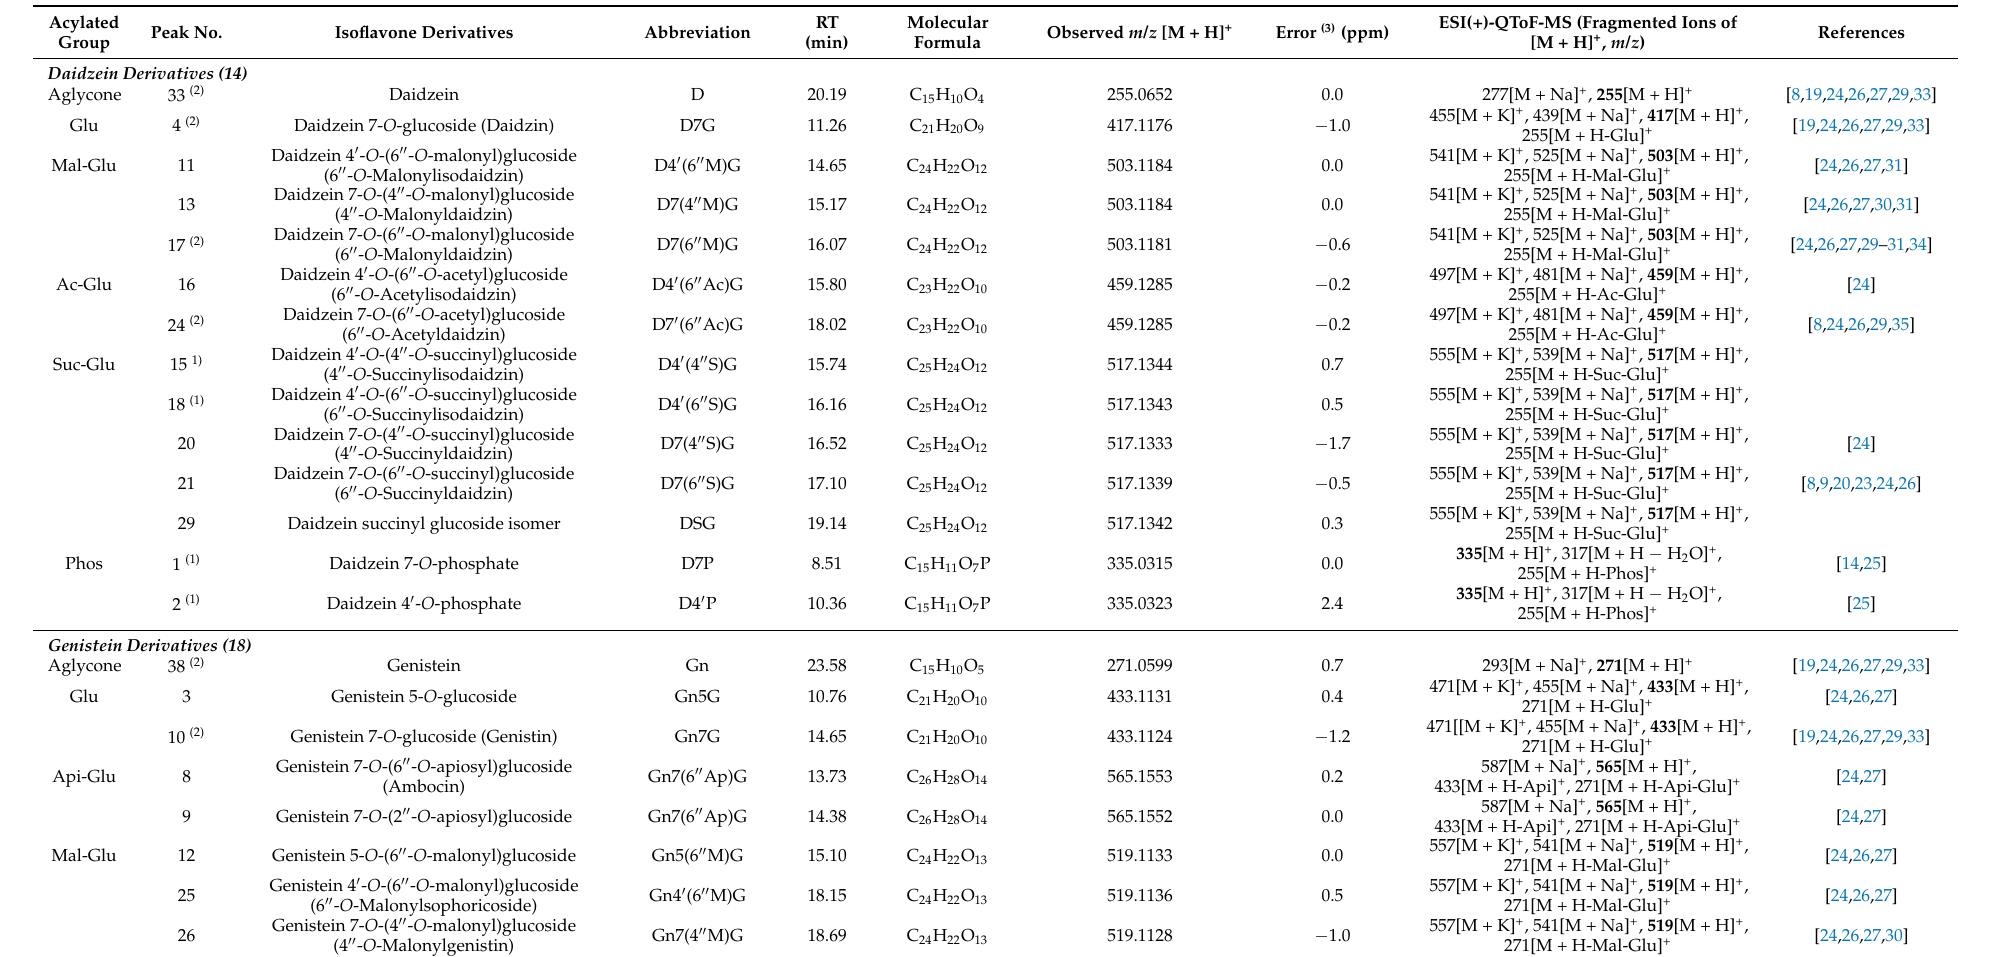
Table 1. Characterization of thirty-eight isoflavones from the raw, steamed and fermented (by B. subtilis AFY-2) soybean seeds based on UPLC-DAD-QToF/MS. Acylated